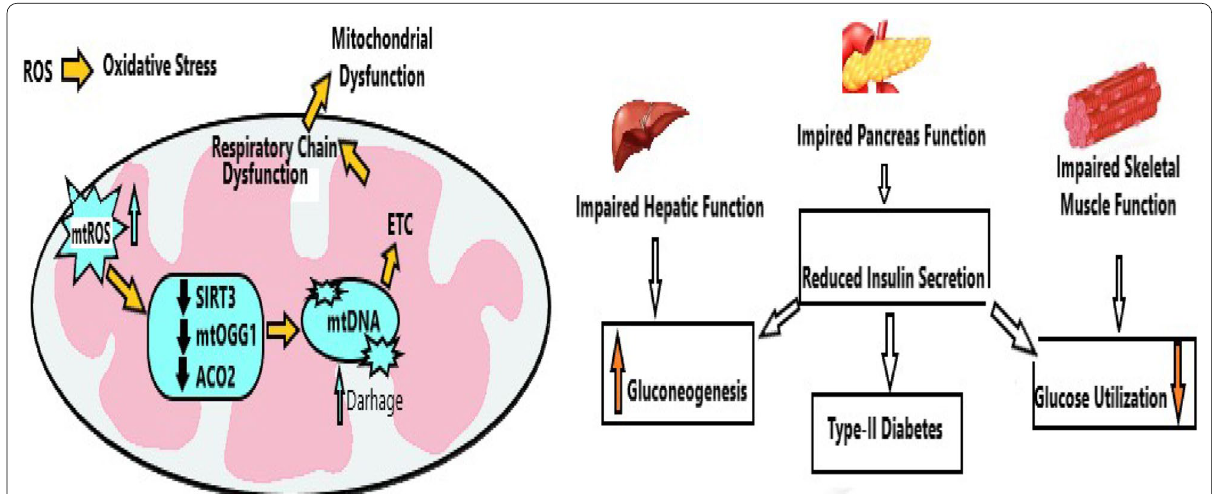
Fig. 2 ROS mediated oxidative damage causing mitochondrial dysfunction and to type 2 diabetes. ROS: Reactive Oxygen Species; ETC: electron transport chain; mtDNA: Mitochondrial DNA; SIRT3: sirtuin (silent mating type information regulation 2 homolog) 3; mtOGG 1: mt human 8-oxoguanine glycosylase 1; ACO2: